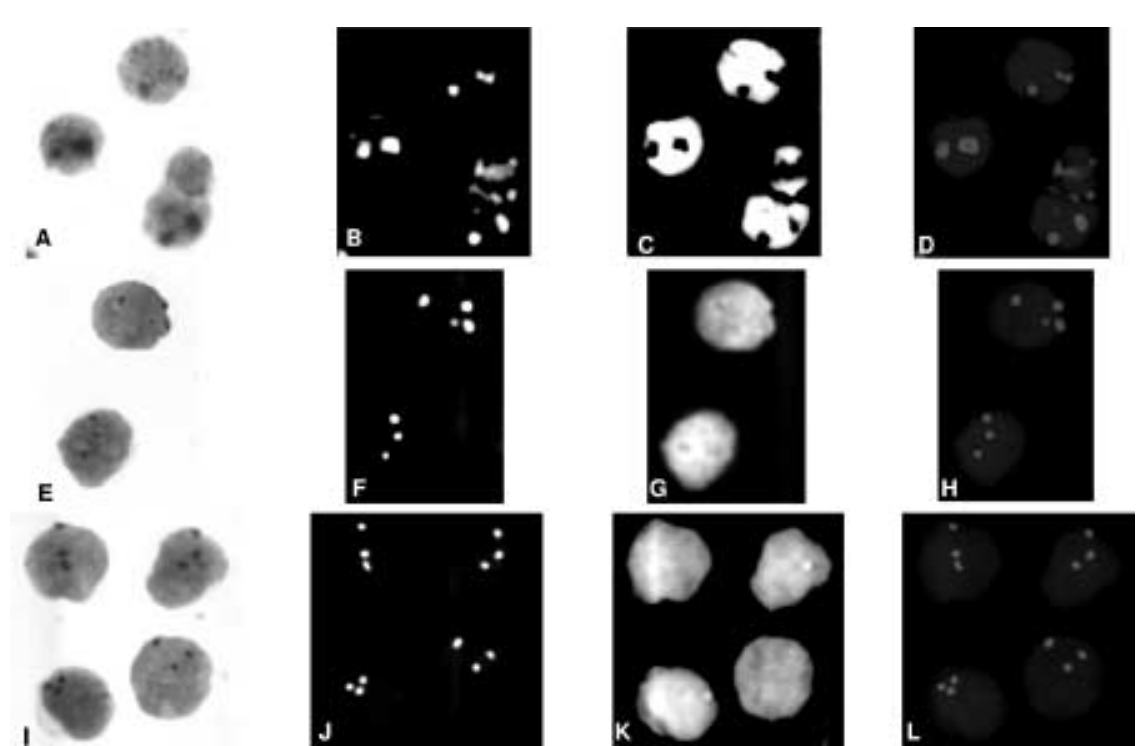
Fig. 2. Spectral analysis of a single-color ISH experiments on T24 cells using a specific probe for the centromere of chromosome 1 visualized with (A–D) DAB, (E–H) New Fuchsin, (I–L) Fast Red, and counterstained with hematoxylin. Panels A, E, and I show the raw microscopic image before spectral analysis. Panels B, F, and J show detection of the ISH signals after spectral decomposition in gray-scale images in which the intensity is proportional to the concentration of the dye. Panels C, G and K show the detection of hematoxylin counterstained nuclei. Panels D, H and L are merged gray-scale images in pseudo-colors showing ISH signals in red and nuclei in blue.